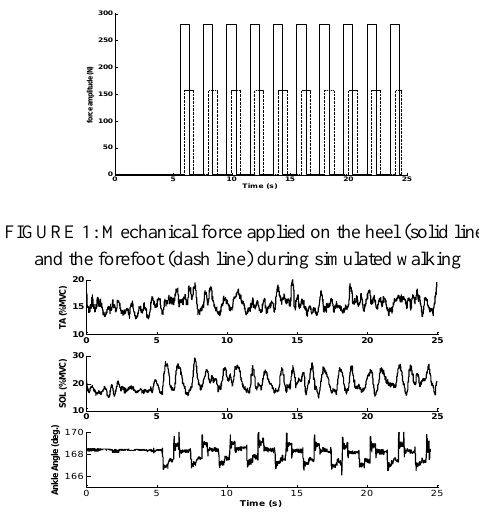
FIGURE 2: EMG and anke angle during walking